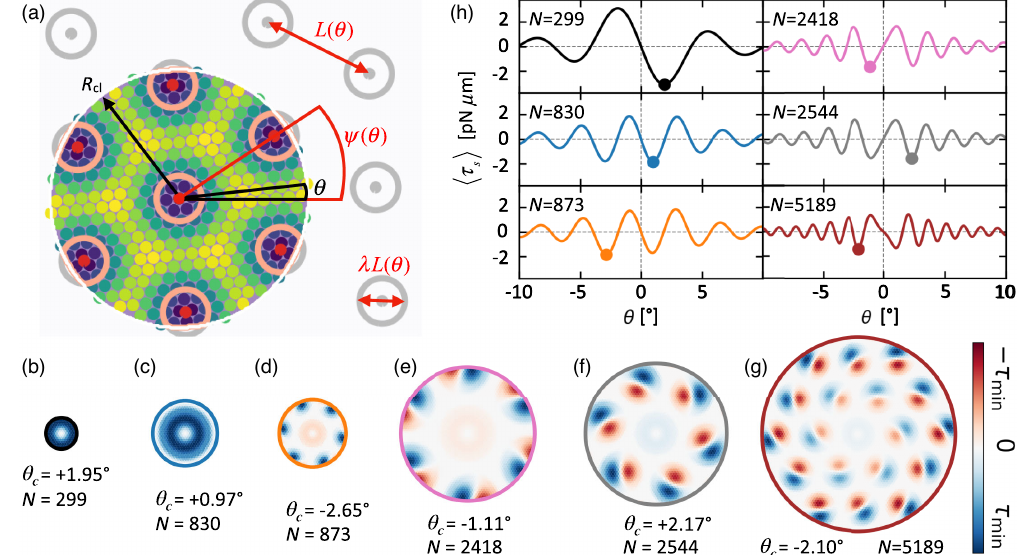
FIG. 3. Angle dependence of the average substrate torque of different-sized clusters and the corresponding critical configurations. (a) Comparison of the microscopic model and the coarse-grained model. We assume circular-shaped clusters with lattice misalignment angle θ relative to the substrate lattice. In the microscopic model, discrete particles are considered and their energies [color code as in Figs. 1(e) – 1(h)] are summed up to calculate the interaction energy h ϵ . Instead, the coarse-grained model focuses on the periodically s i arranged moir´e spots (red and gray circles). These moir´e spots are Gaussian energy-density profiles of width λ L which contribute to h ϵ s i if they are covered by the cluster (red). (b) – (g) Local torque distributions of simulated (with the microscopic model) circular clusters at their depinning angles θ ¼ θ (reported in the corresponding panel) on a δ ¼ 3 . 3% surface. Individual particles are color coded c according to their local substrate torque τ (Appendix C). The τ values for the six cluster sizes reported here are marked by arrows in s c 0 and b ¼ 4 . 6 μ m ( δ ¼ 3 . 3% ) for the six cluster Fig. 2(c). (h) h τ versus θ , as obtained from Eq. (2) (coarse-grained model) for r s i cm ¼ sizes as shown in (b) – (g). The filled dots on the curves mark the respective global minima θ c